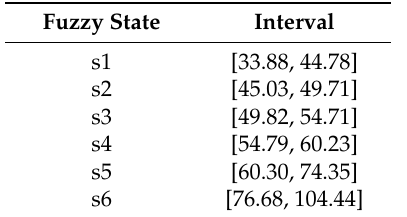
Table 2. From fuzzy state to interval.